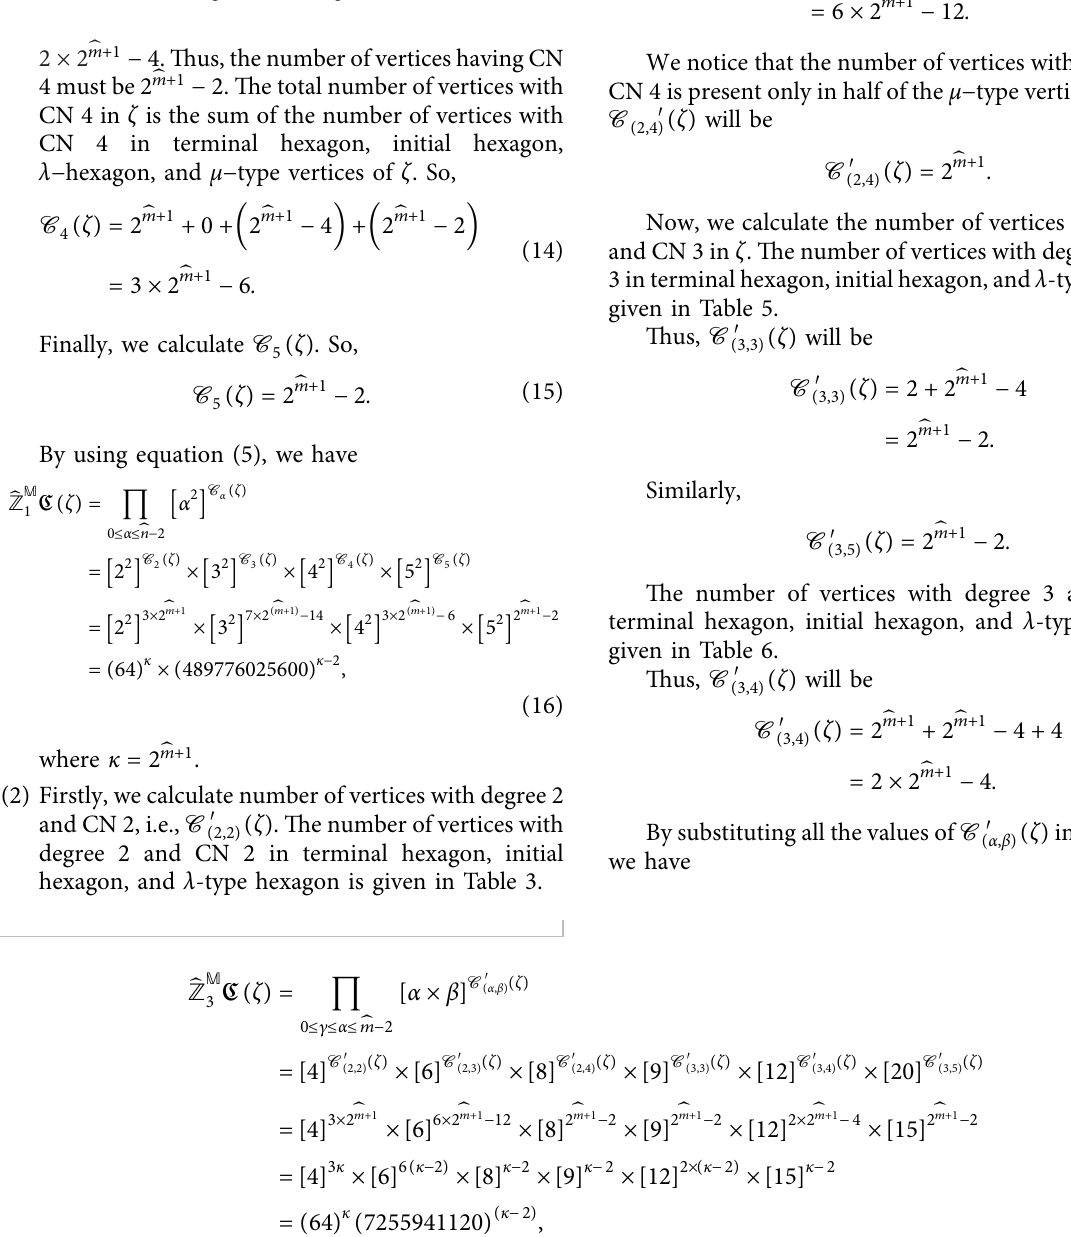
Figure 4: D [ 2 ] along with the degree of each 1